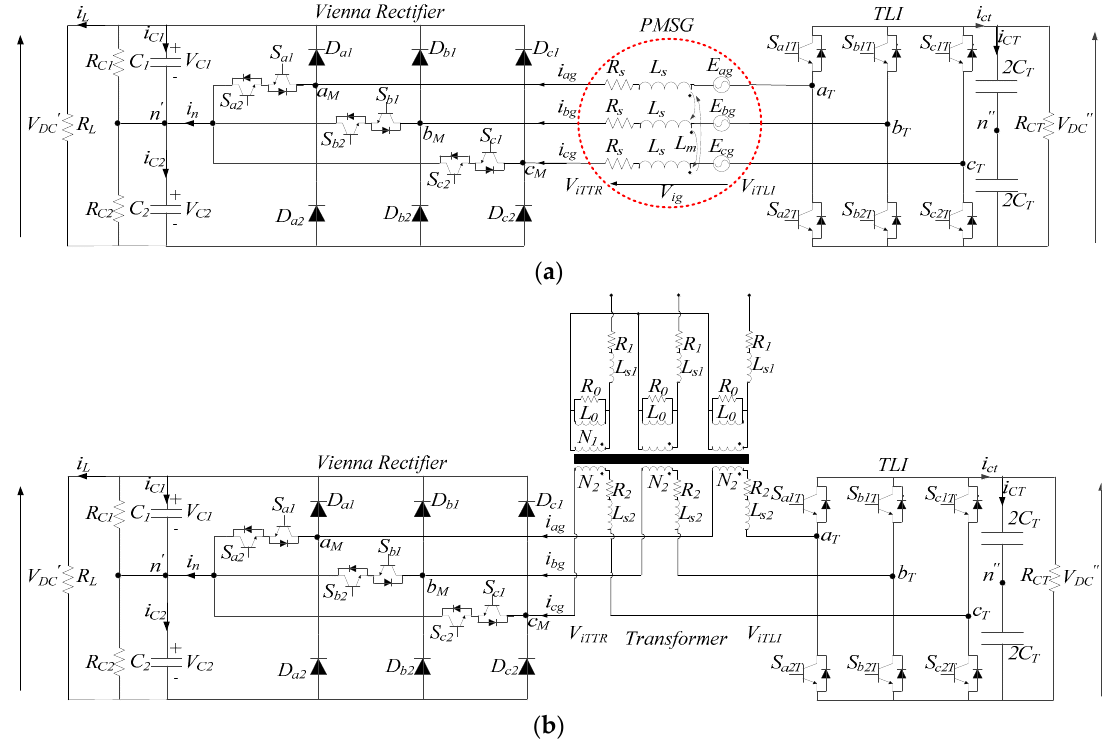
Figure 1. AHUTR for electrical power generation ( a ) and grid-connected ( b ) applications.